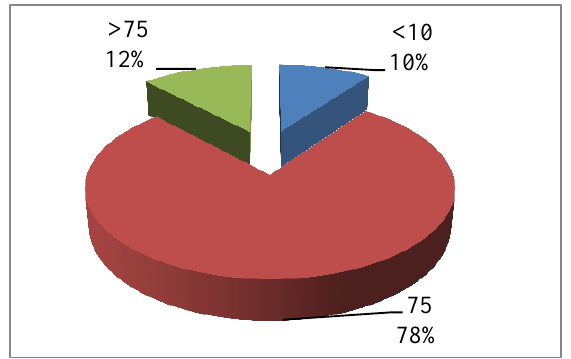
Fig. 6. Characterization of proteins by molecular weight of C. tropicalis , fungi cells obtained with frosting-